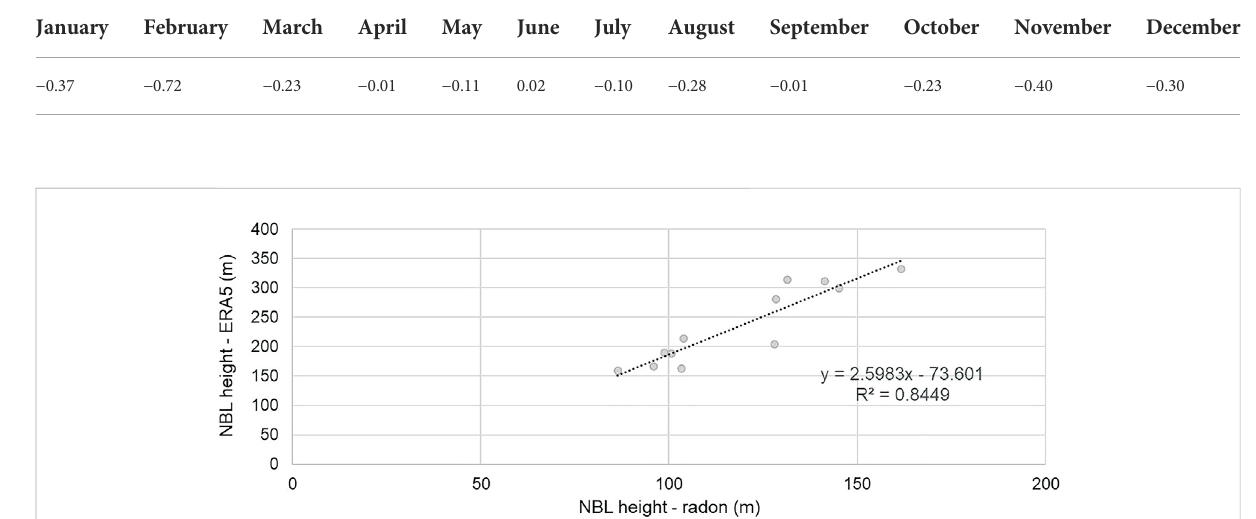
TABLE 2 The monthly averaged correlation coef fi cient ( p < 0.001) between radon and air temperature.